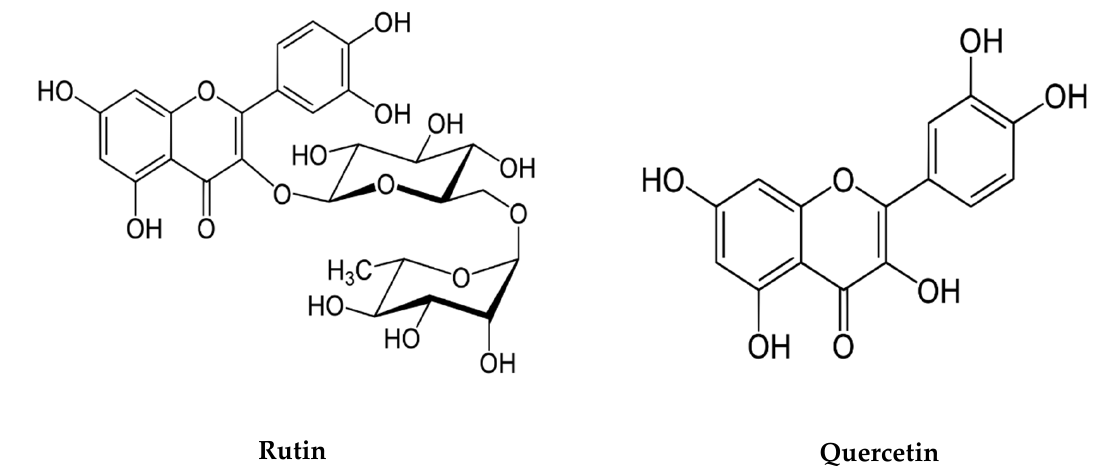
Quercetin Rutin